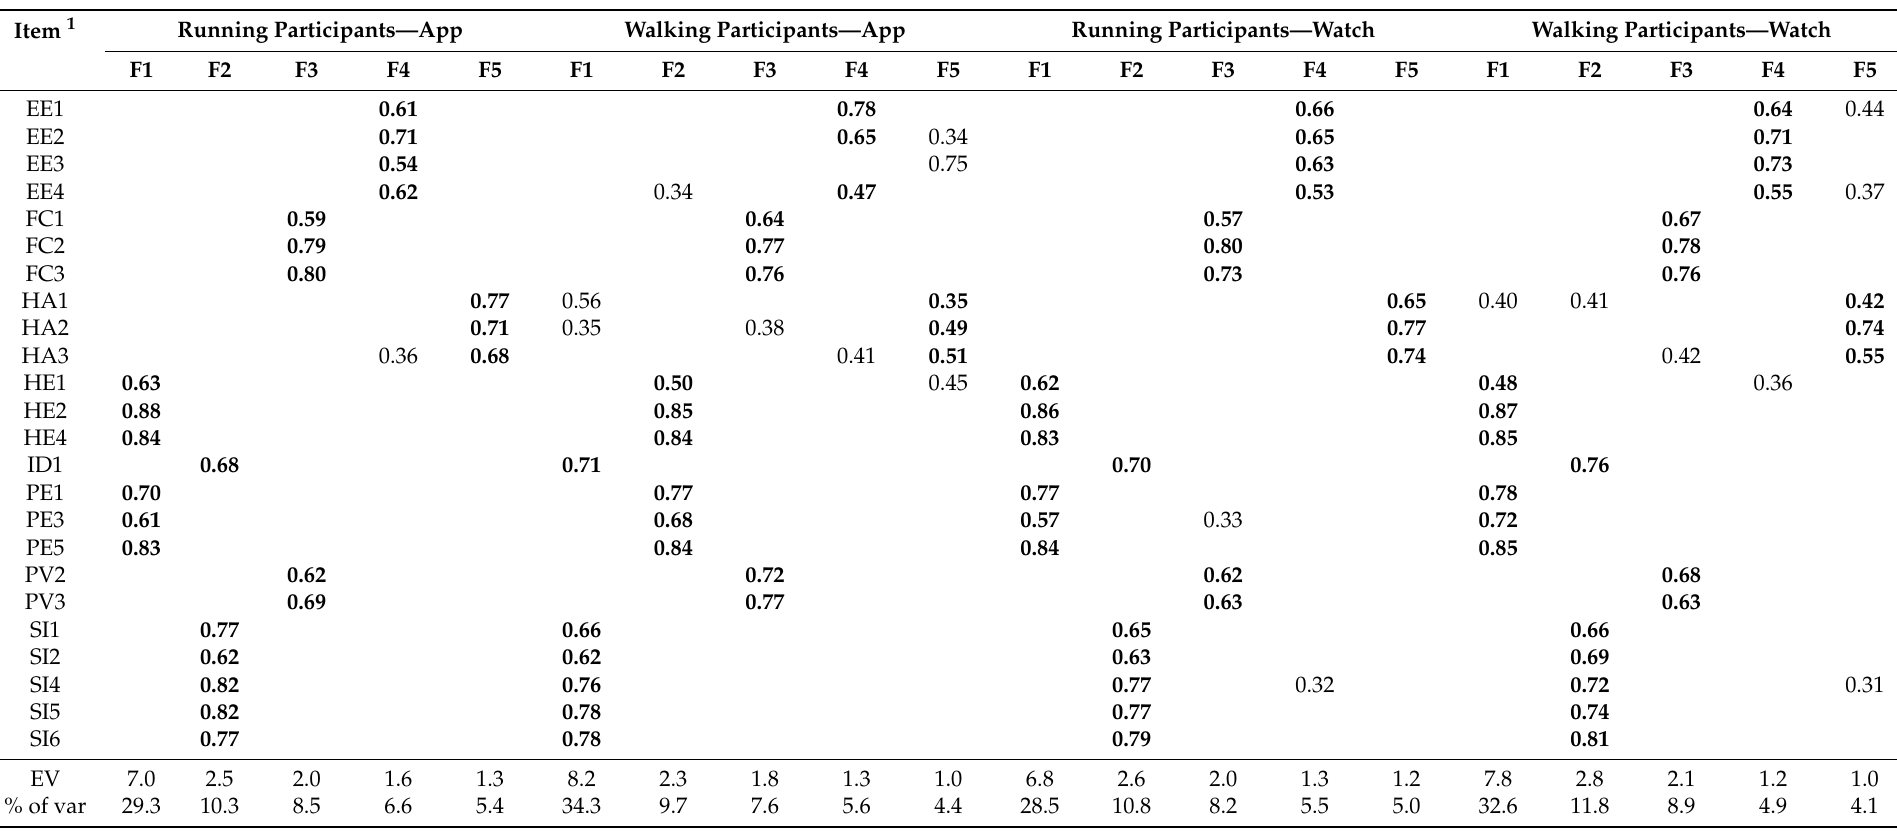
Table 2. Final exploratory factor analyses of the scale to measure the motivation of the use applications and sports watches among running and walking